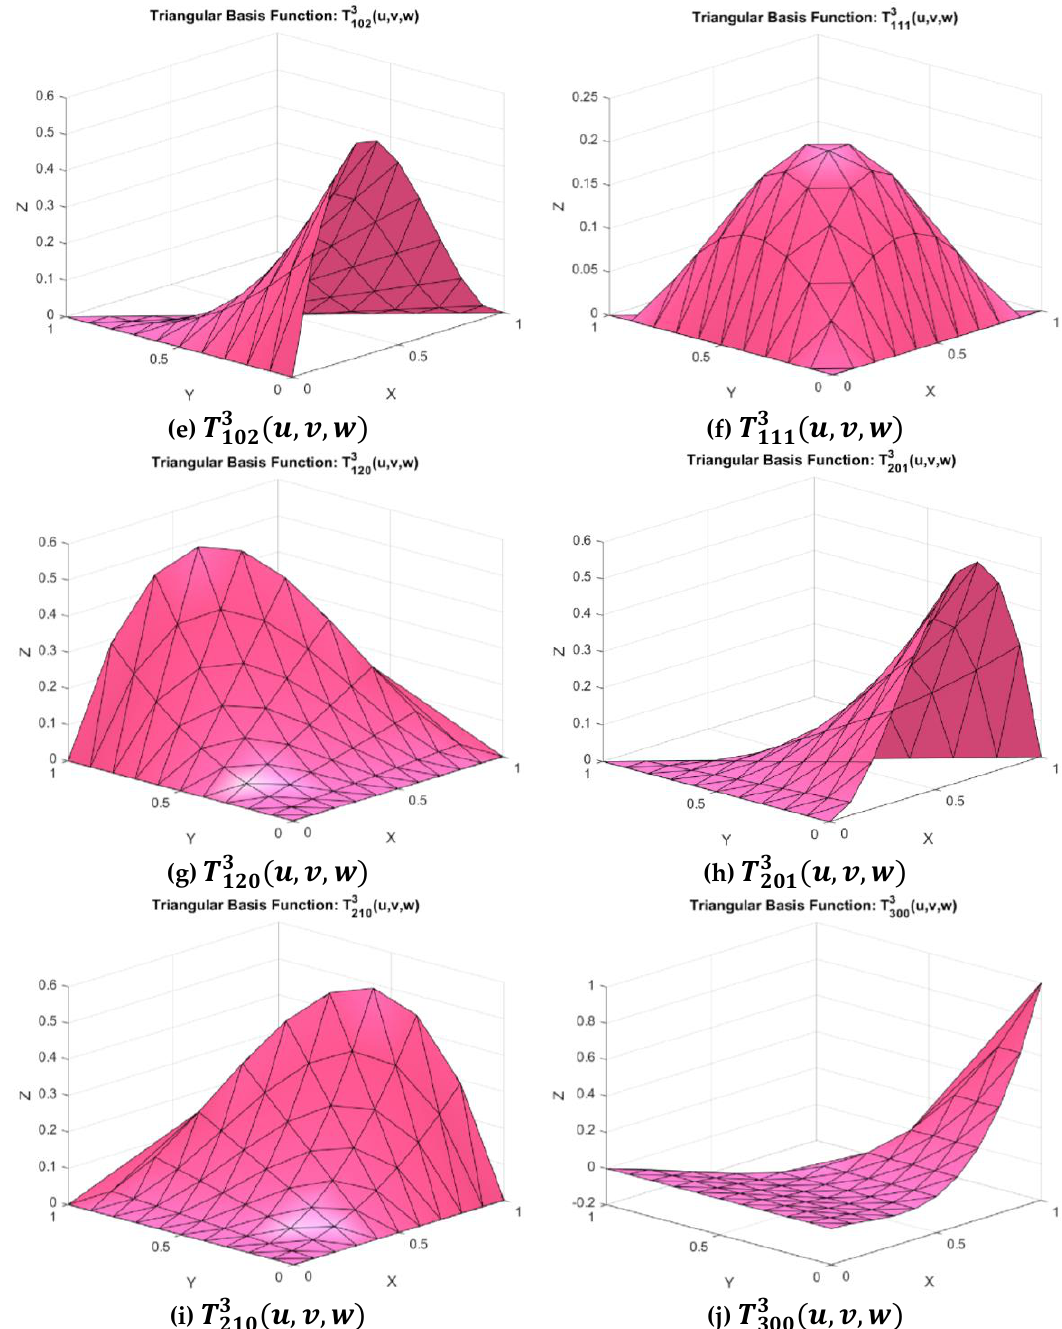
Figure 1. Some cubic Timmer triangular basis functions.